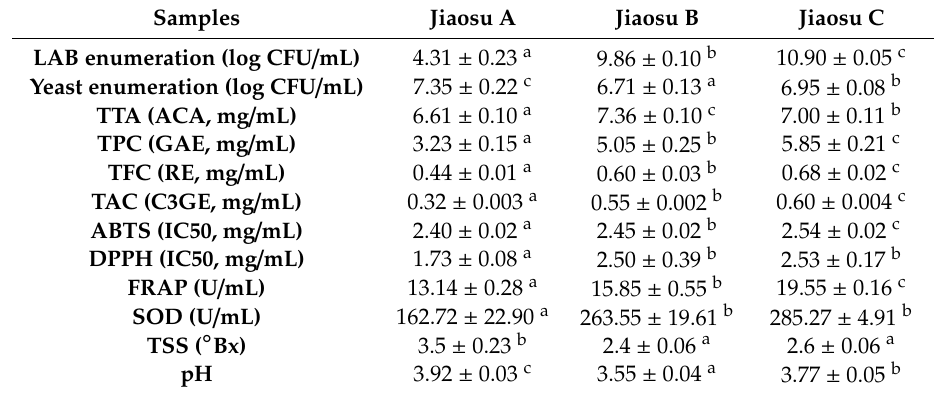
Table 2. Total lactic acid bacteria (LAB) and yeast enumeration and antioxidant characteristics of all samples.